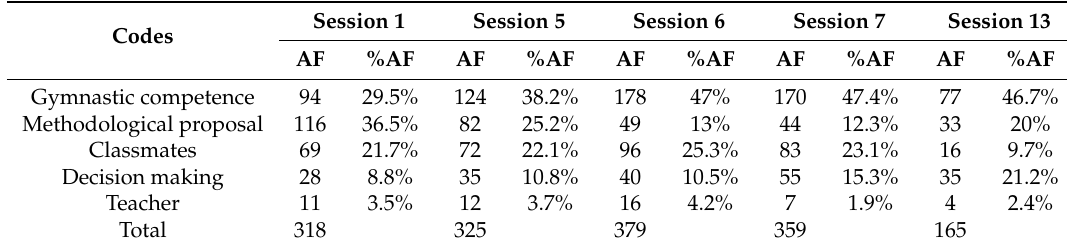
Table 3. Motivations for satisfaction with gymnastics learning, by